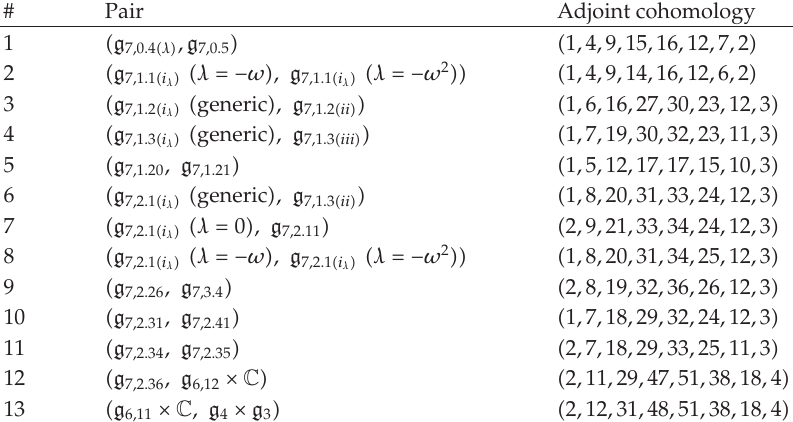
Table 2: Pairs of 7-dimensional NLAs having same adjoint cohomology.